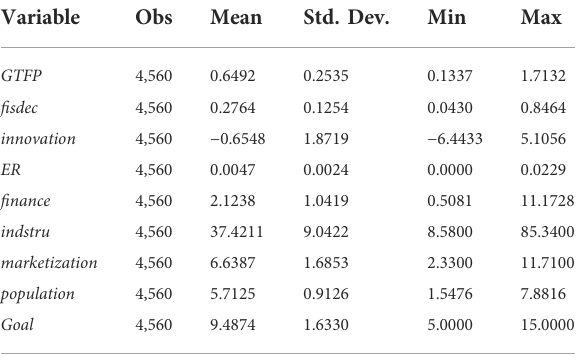
TABLE 1 Statistical characteristics of variables.